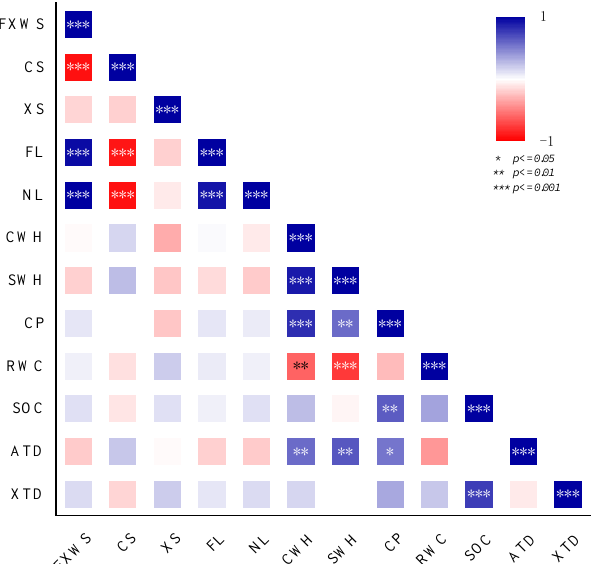
Figure 9. Correlation changes between soil physical and chemical properties and fractal dimen- sion.